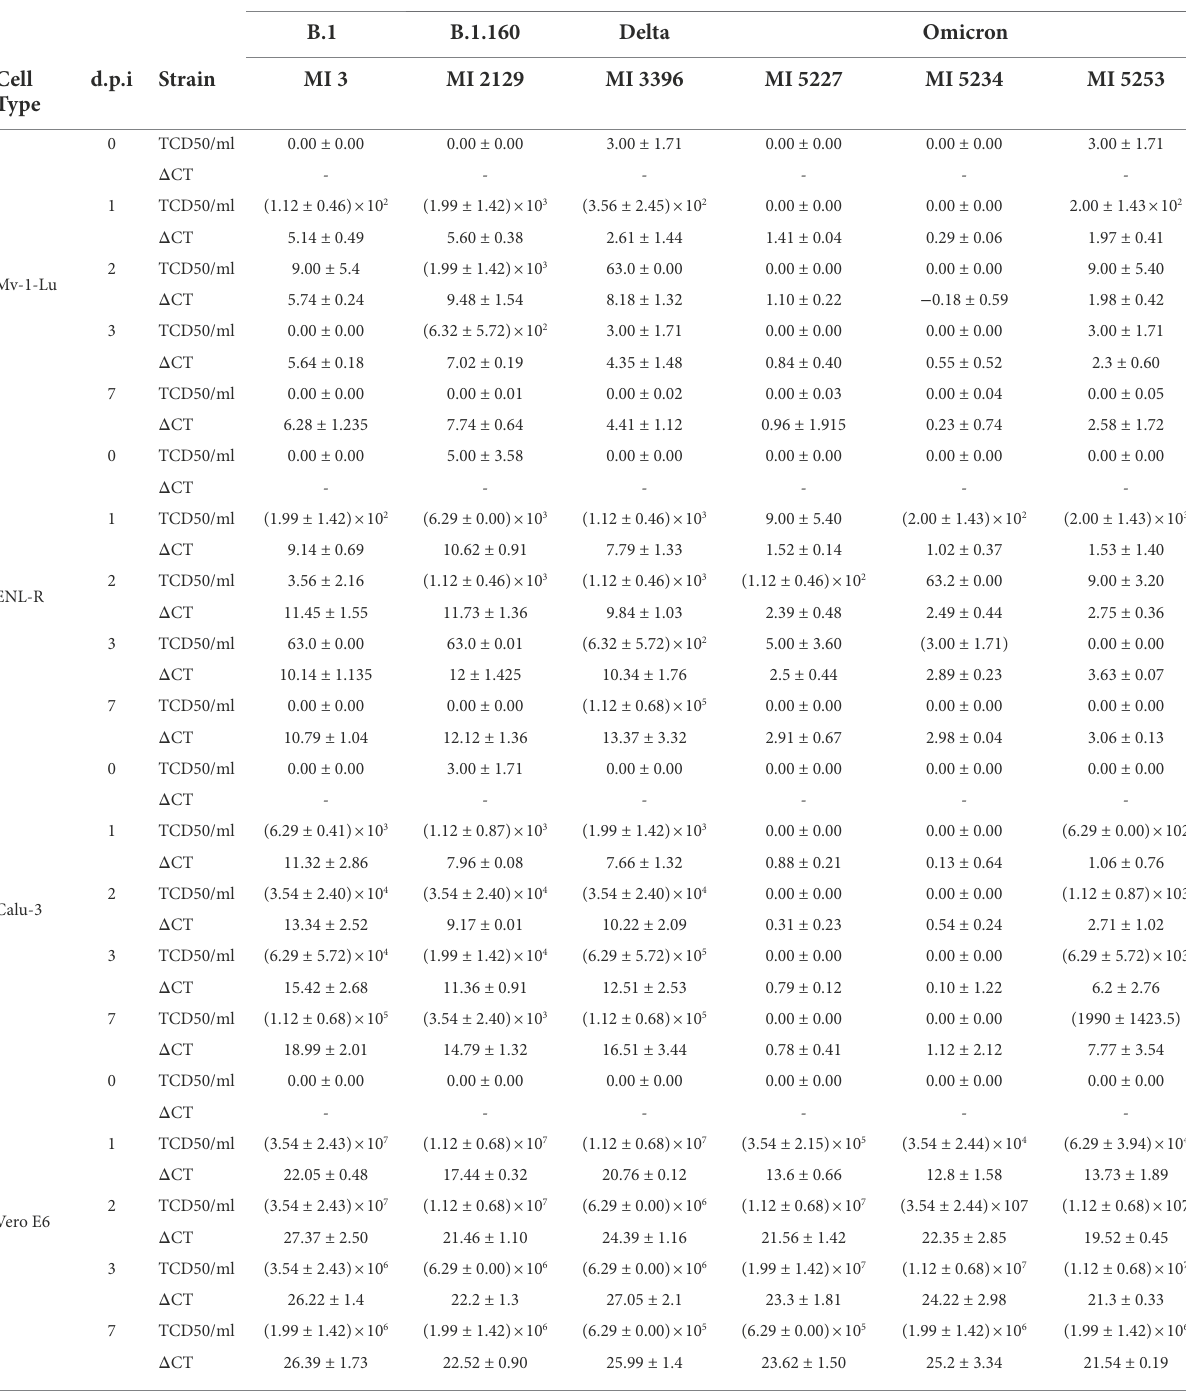
TABLE 2 Viral production of SARS-CoV-2 of different strains in mink lung cells over 7